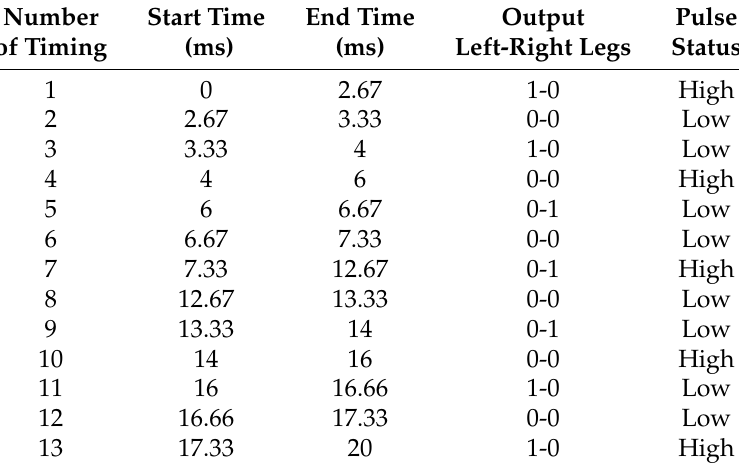
Table 2. Timing and sequence of the